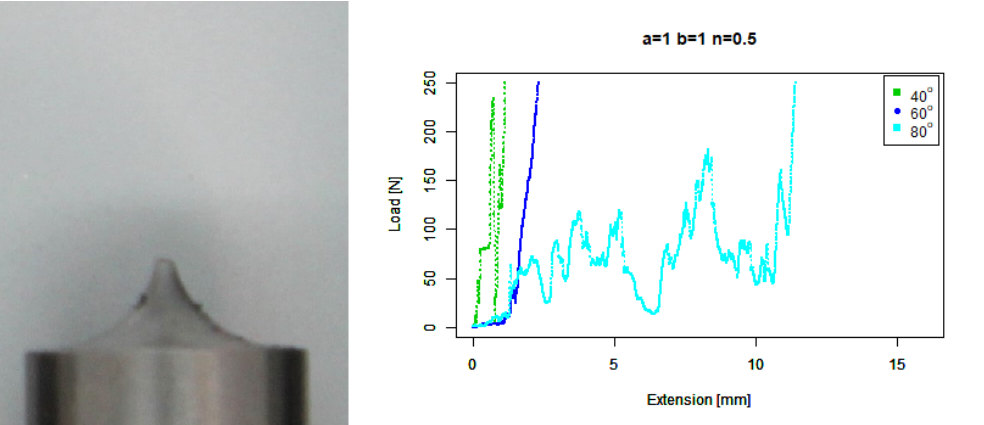
Figure 7. Basic concave tip. ( Left ) Tip Profile. ( Right ) Experimental